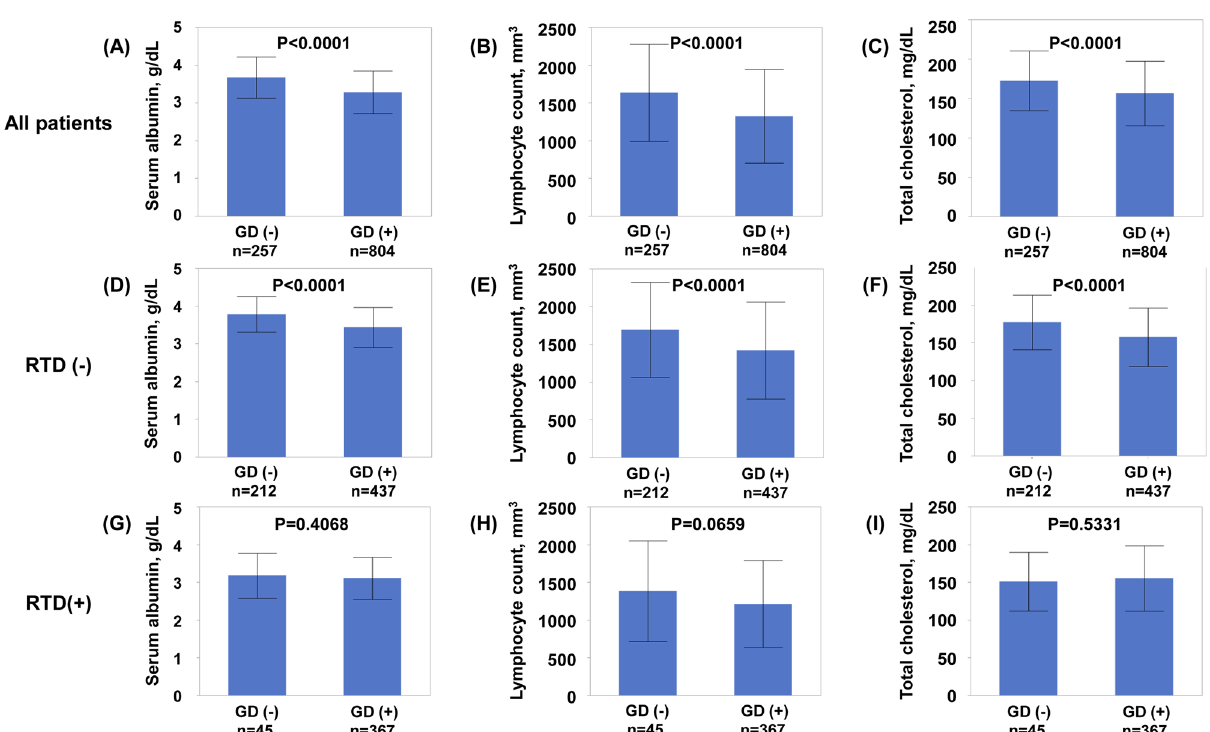
Figure 4. Association between controlling nutritional status score components and GD in all heart failure patients ( A–C ), in heart failure patients without RTD ( D–F ), and in heart failure patients with RTD ( G–I ). GD glomerular damage, RTD renal tubular